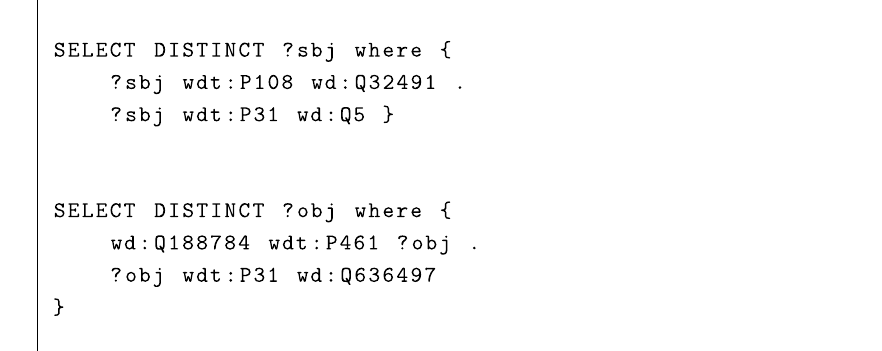
Fig. 10 Two questions with the same POS tags but different kinds of graph pattern